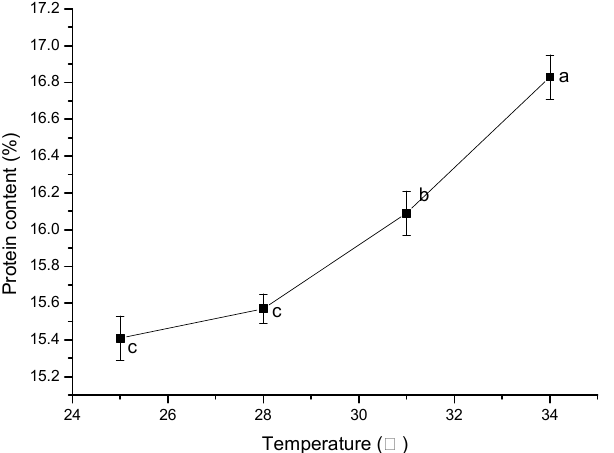
Figure 7. The single-factor experiments for the fermentation temperature in the second stage of the solid-state fermentation. Experiments were performed in triplicate (n = 3). Sites not sharing a com-